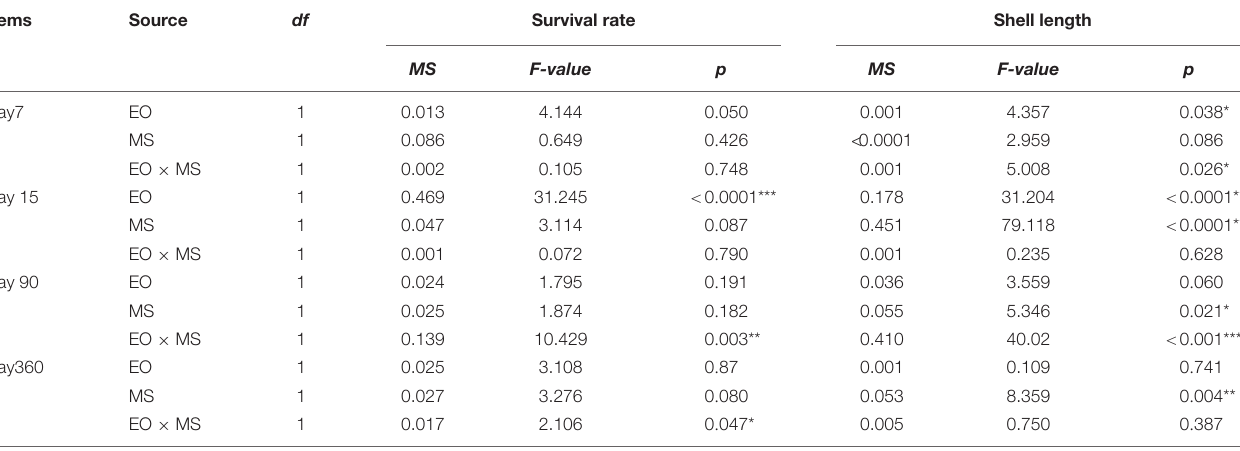
TABLE 3 | Analysis of variance (ANOVA) showing the egg origin (EO) and mating strategy (MS) effects for survival and growth of each experimental group at different time points. Items